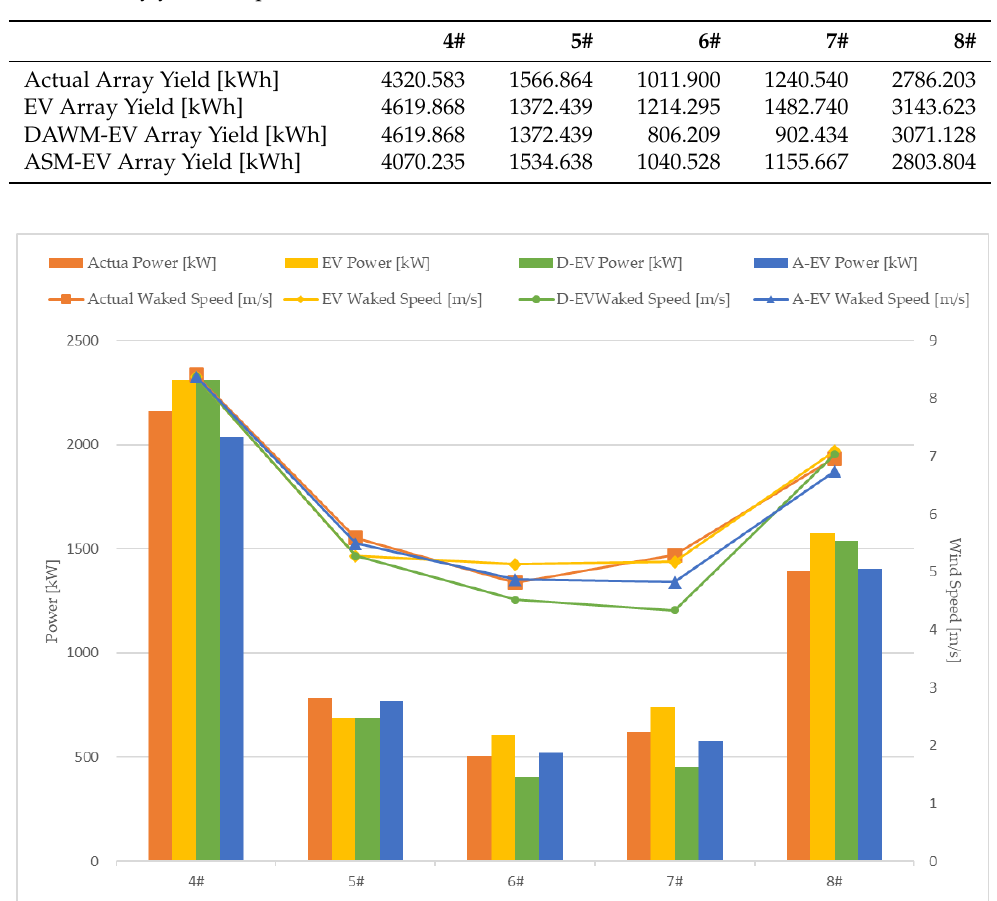
Table 6. Array yield comparison.